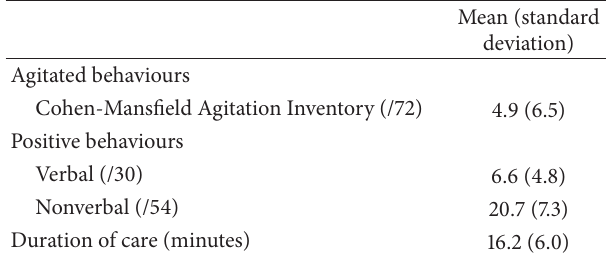
Table 4: Residents’ behaviours during care and mean duration of